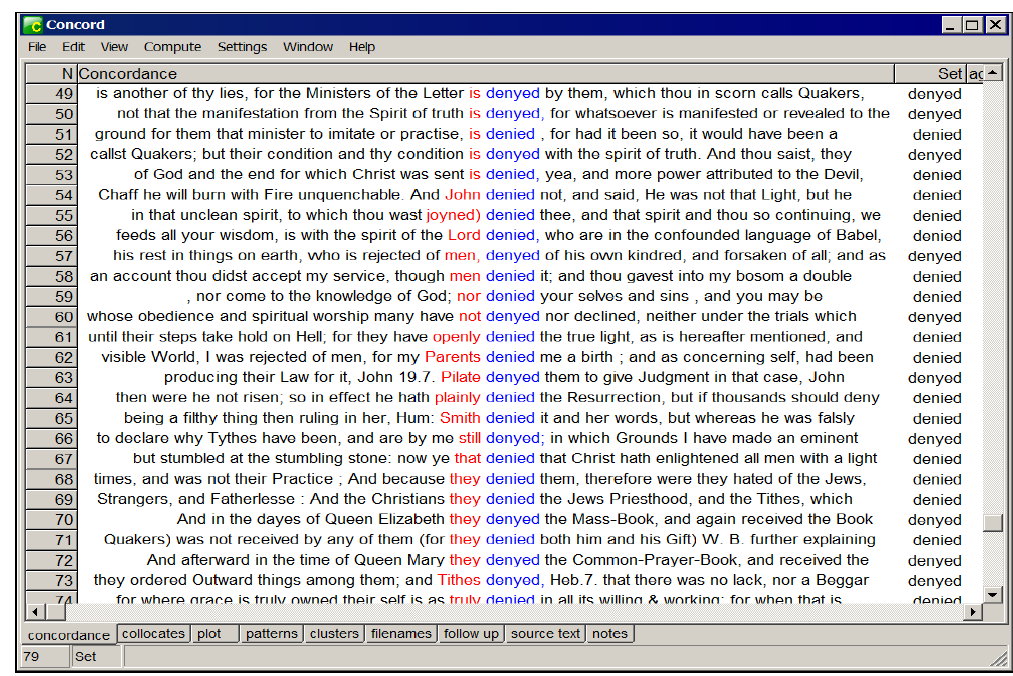
Figure 6. Illustrative concordance lines for both node spelling variants denied and denyed. Religions 2018 , 9 , x FOR PEER REVIEW